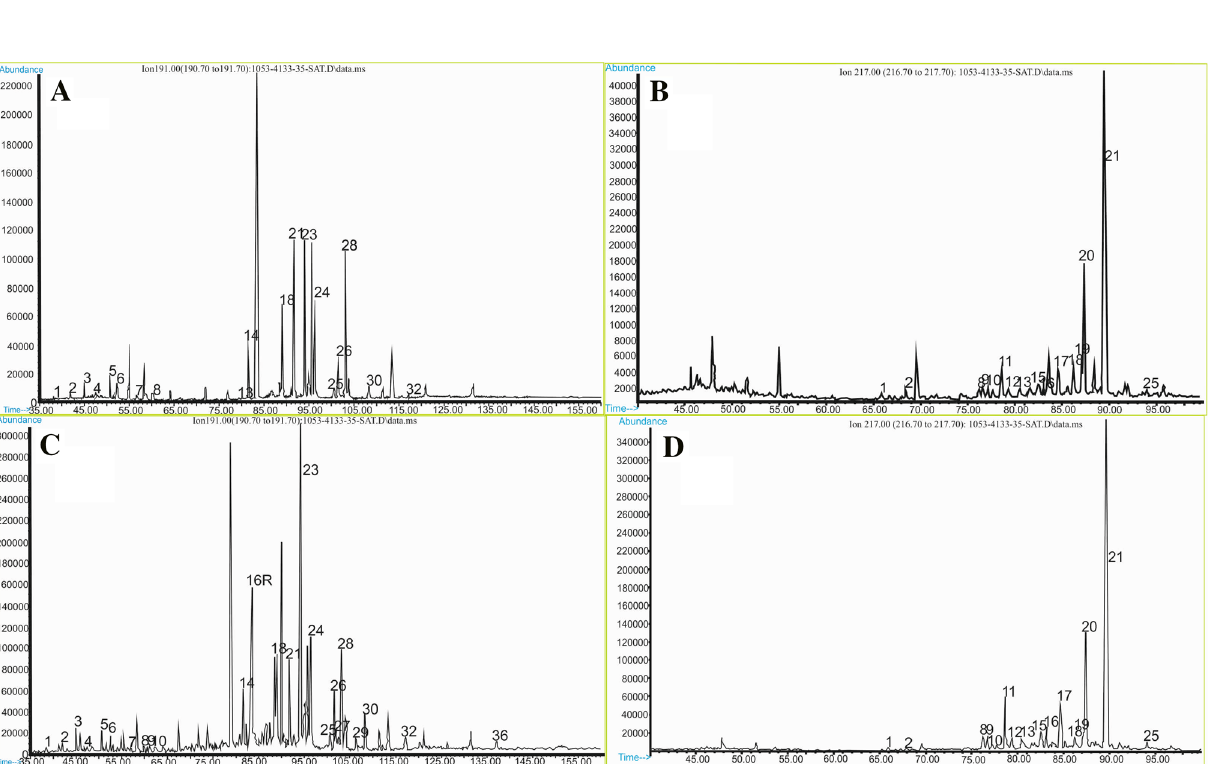
Fig. 10 m / z 191 and 217 mass chromatograms of Turabi shale sample (Cin-15a) (a, b), (c, d) m / z 191 and 217 mass chromatograms of Halıkışlak peat samples (a, b)